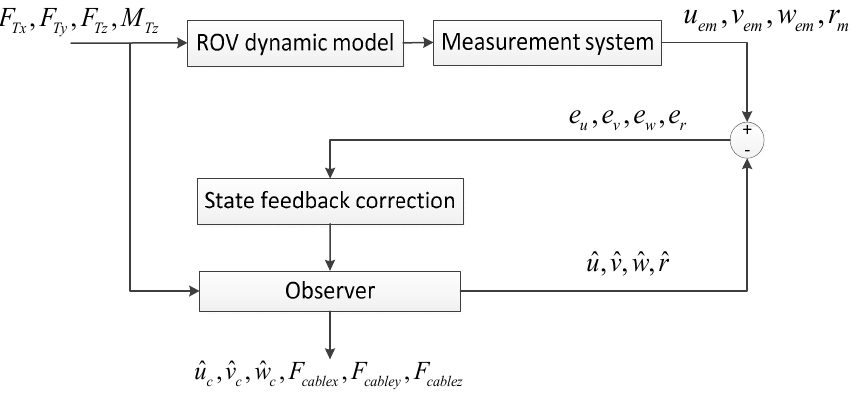
Figure 8. Observer structure.